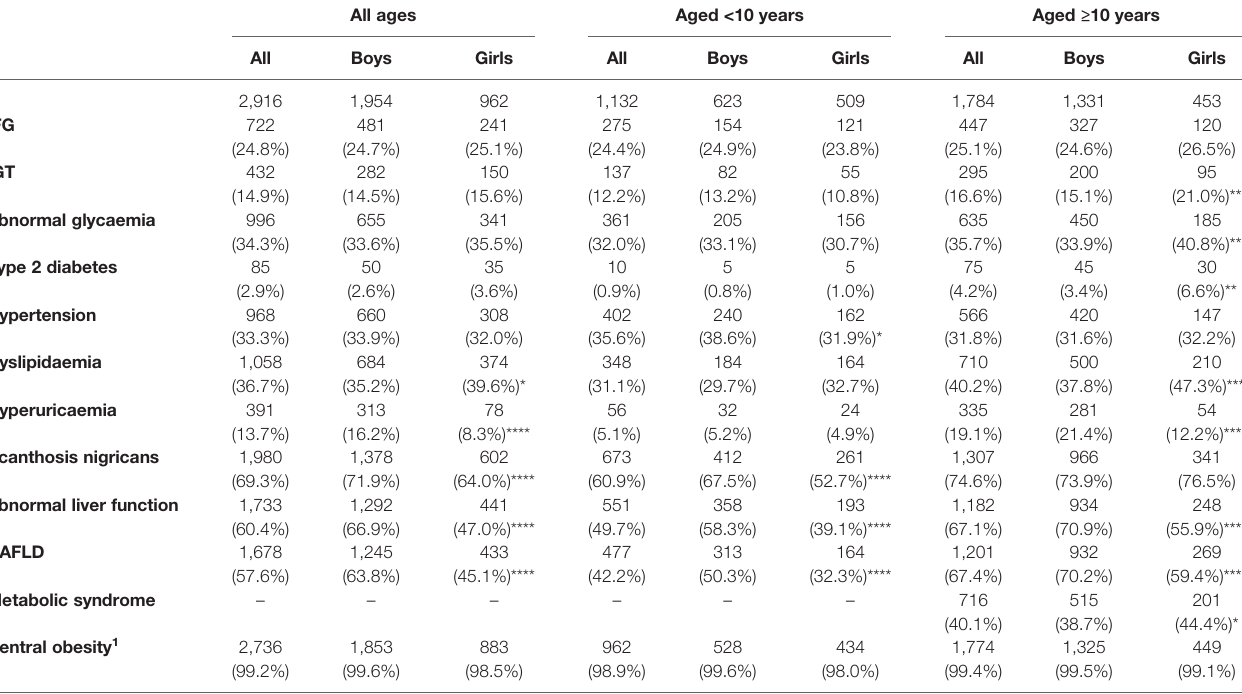
TABLE 3 | Incidence of cardiometabolic comorbidities among children and adolescents with obesity assessed between 2008 and 2017 in Hangzhou (Zhejiang Province, China).